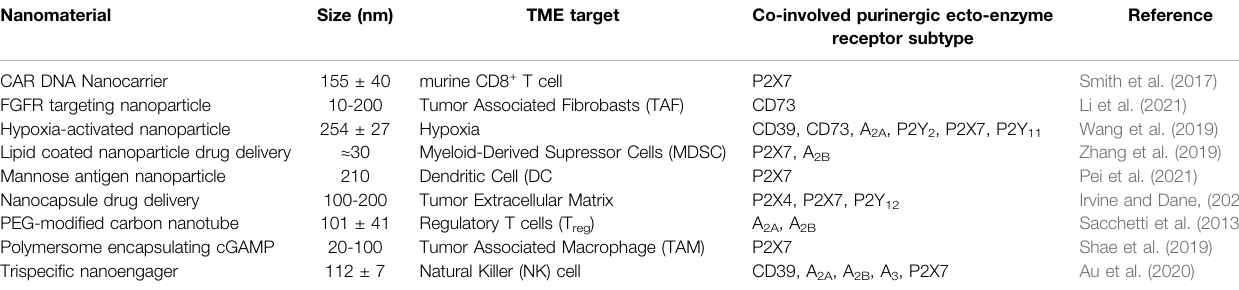
TABLE 1 | Examples of immunomodulatory nanoparticle types, tumor microenvironment (TME) interactions and co-involved purinergic pathways.